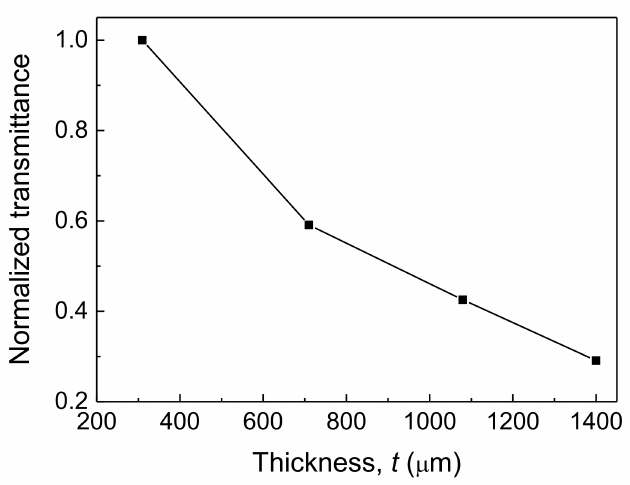
Figure 10. Transmittances of LC cells at t = 310 µ m, 710 µ m, 1000 µ m, and 1400 µ m in a separate